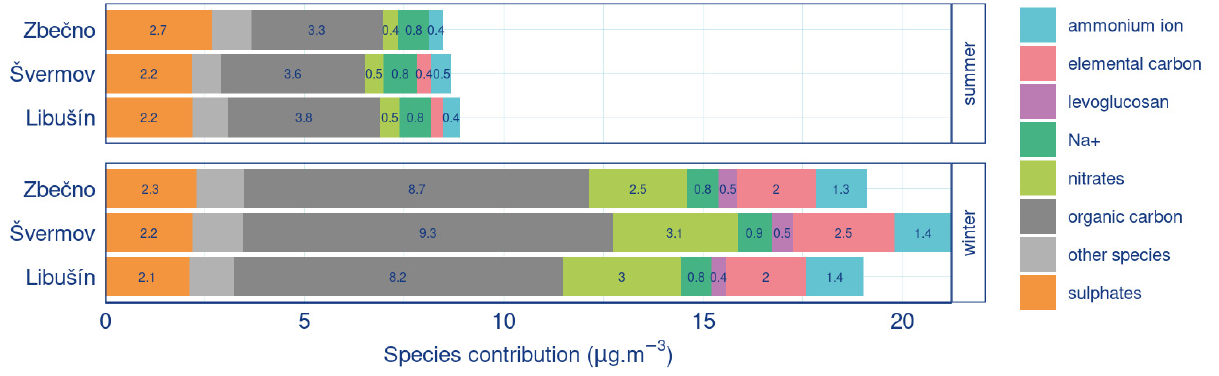
Figure 3. Mass composition of PM 2.5 .